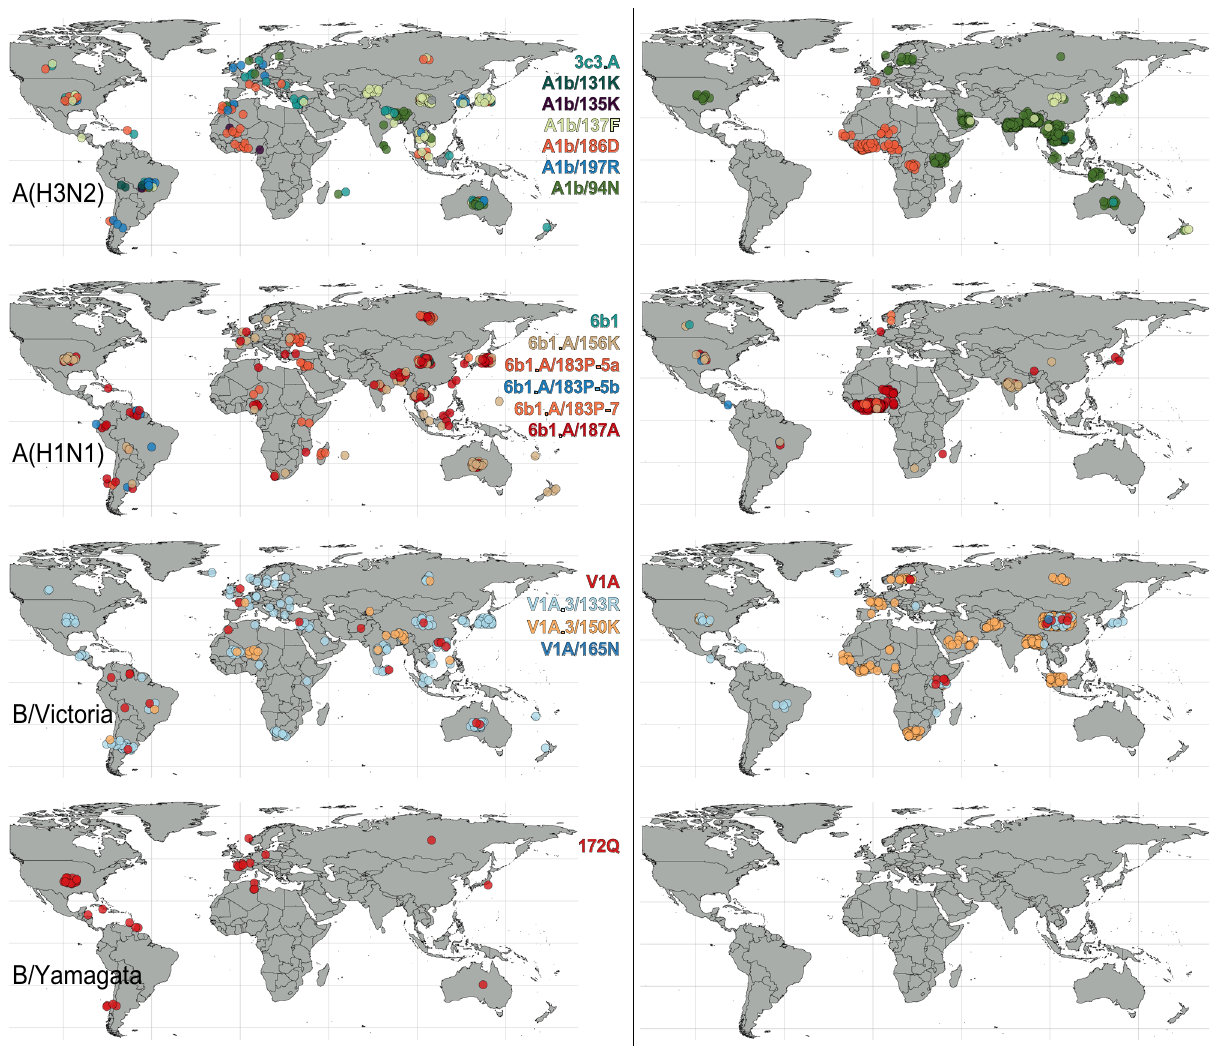
Fig. 4 Geographic distribution of in fl uenza HA sequences before (left) and after (right) COVID-19 emergence. From April 2020 to July 2021, A(H3N2) (590 sequences from 32 countries), A(H1N1) (254 sequences from 18 countries), and B/Victoria (834 sequences from 34 countries) were available for analysis. In comparison to the 16-month period before April 2020 (December 2018 to March 2020), there was a reduction in sequences of 97% for A(H3N2), 99% for A(H1N1), 92% for B/Victoria, and 100% for B/Yamagata. Last updated on 24 August 2021; for an interactive visualization of current seasonal in fl uenza circulation, we refer the reader to the Nextstrain 67